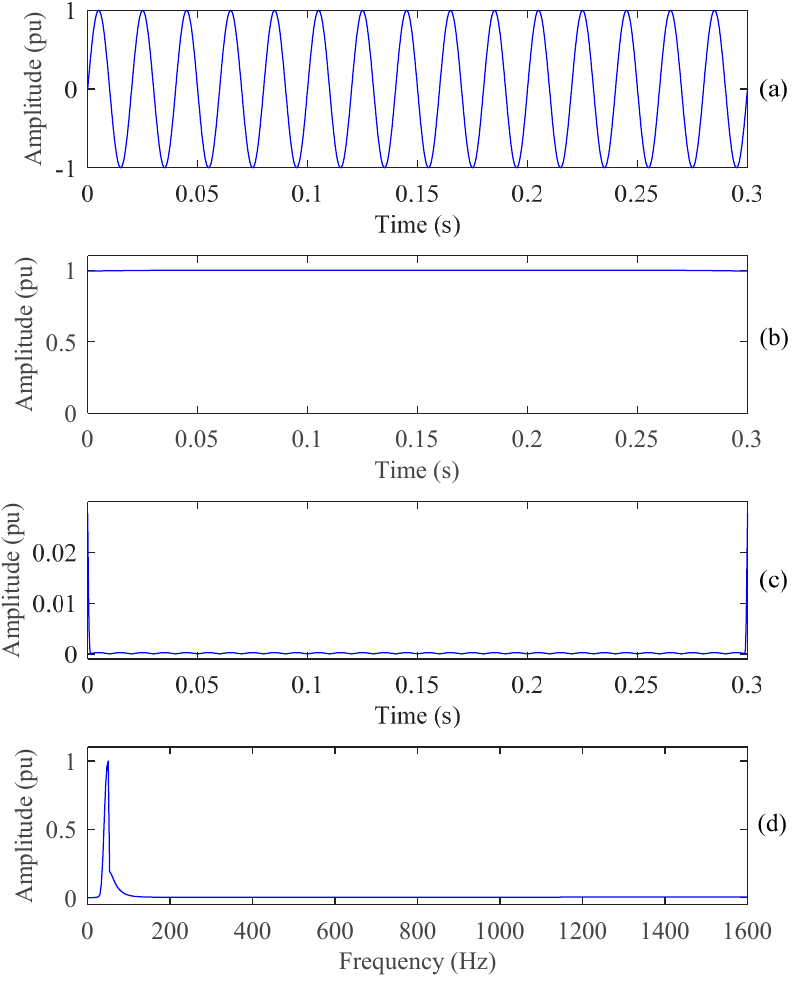
Figure 2. Pure sine voltage and related ST amplitude ( STA) : ( a ) Sine voltage; ( b ) time maximum amplitude ( TvA) ; ( c ) time amplitude of maximum frequency ( TvHFA) ; ( d ) frequency maximum amplitude ( FvA).